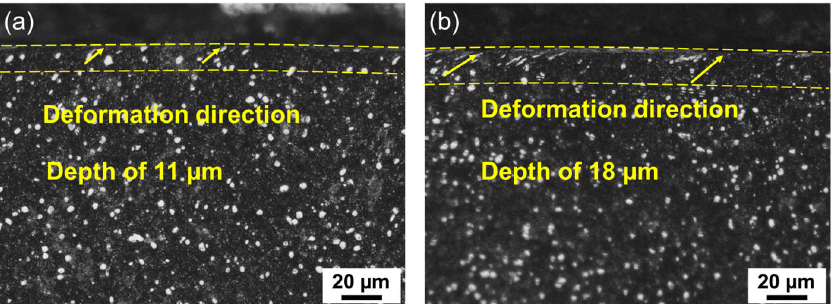
Figure 9. Cross-section microstructure of the turned surface using CCI: ( a ) conventional cutting and ( b ) 0.90 A/mm 2 .